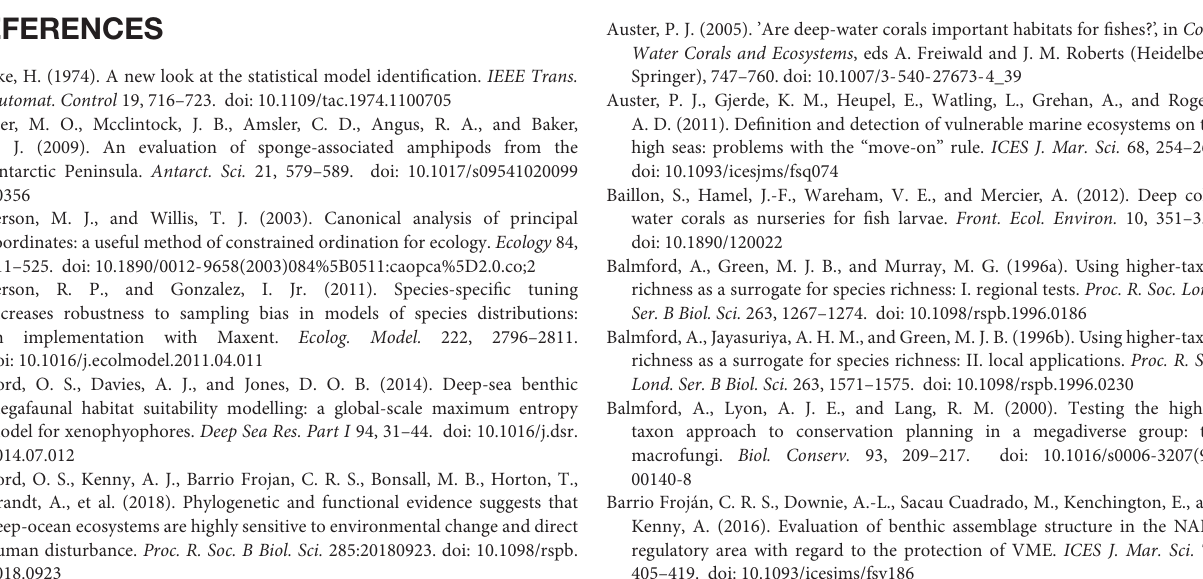
TABLE S2 | Peracarid crustacean genus and family composition per sample. TABLE S3 | Raw biological and environmental data analysed in this